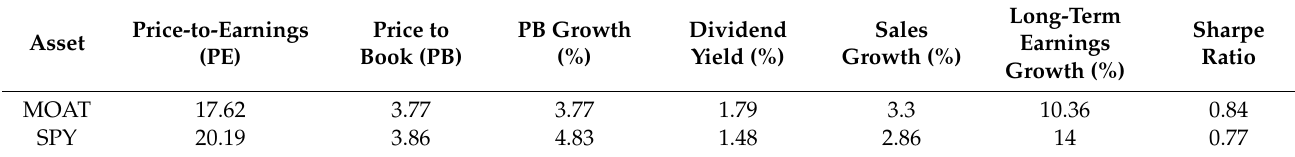
Table 1. Fundamentals of MOAT and S&P